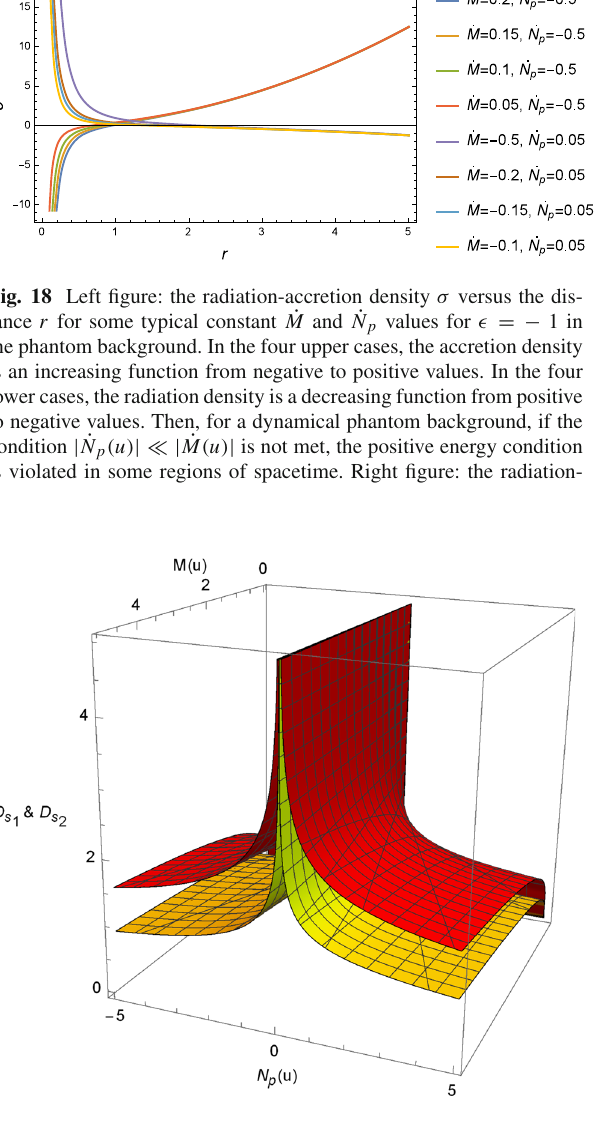
Fig. 19 The variation of D s (yellow plot) and D s (red plot) versus 1 2 typical values of the M ( u ) and N p ( u ) parameters for the phantom back- ground Fig. 20 The variation of R versus typicalvalues of the L and N param- eters in (83) for the phantom background. We have set M = 1 without loss of generality